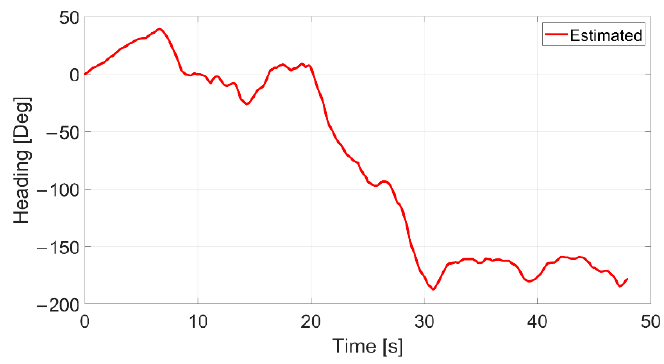
Figure 15. Estimated angle of optical sensor (in red).